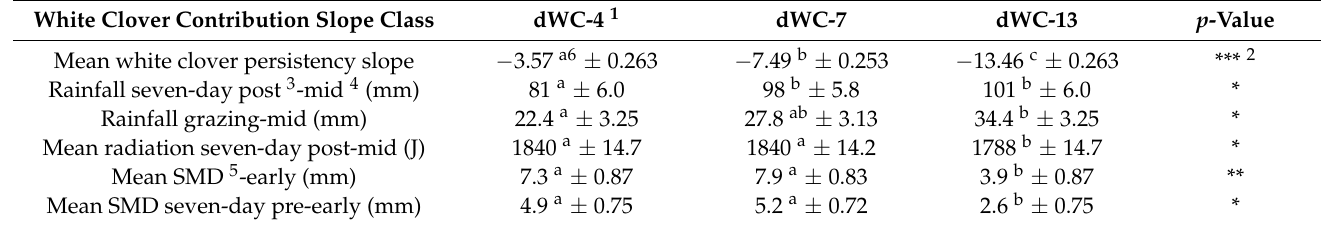
Table 6. Comparison of paddocks in three different declining white clover (dWC) classes in terms of key meteorological parameters (only variables with significant differences ( p < 0.05)